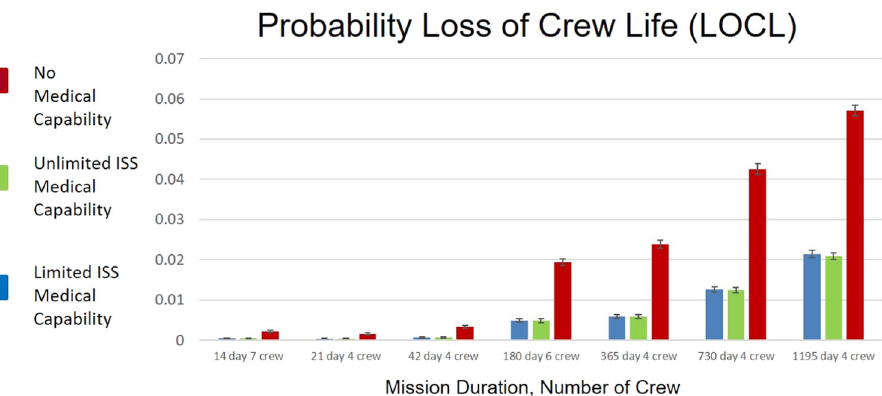
Fig. 5 Calculated likelihood that loss of crew life (LOCL) will occur in-mission due to medical conditions experienced in- fl ight. The 95% CIs is interpreted as the uncertainty estimated with respect to the data informing the 100 medical conditions and the PRA abstraction of the medical event timeline and end-states. As unaccounted uncertainties are not represented in this formulation or data representation, outcomes should be considered as representative of relative changes in risk rather than absolute risk assessments 14 . ISS International Space